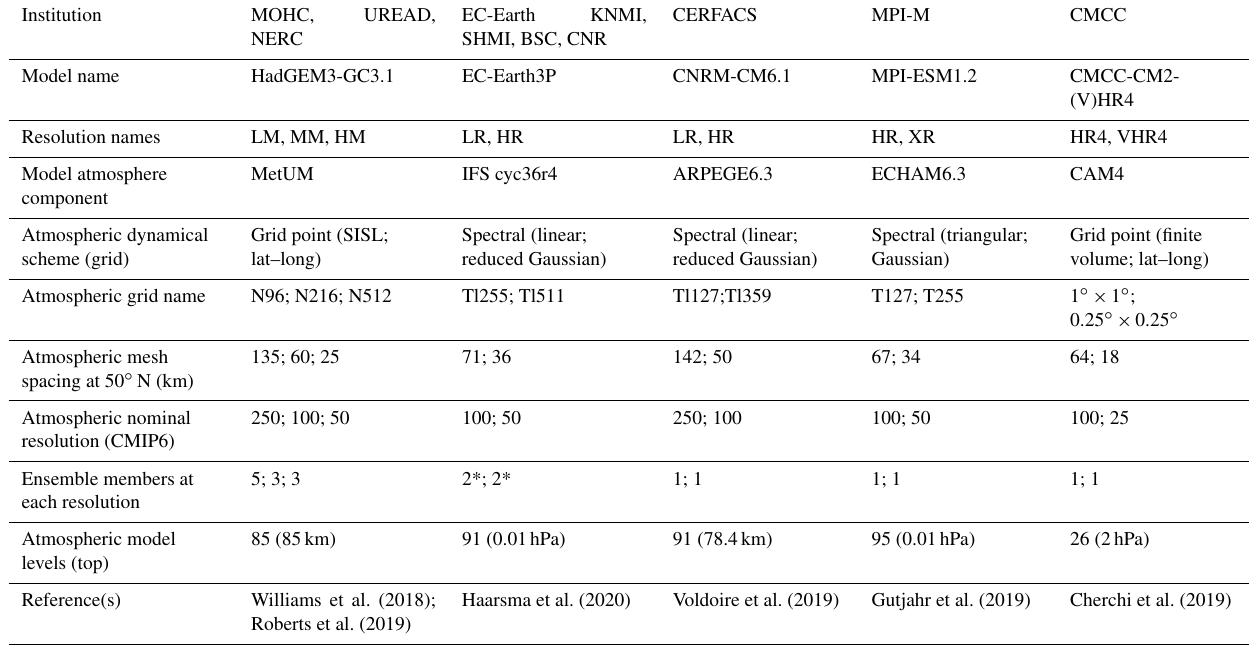
Table 1. Summary of PRIMAVERA models used for the event set. *Only two of the three ensemble members run at each resolution were used due to tracking failures.